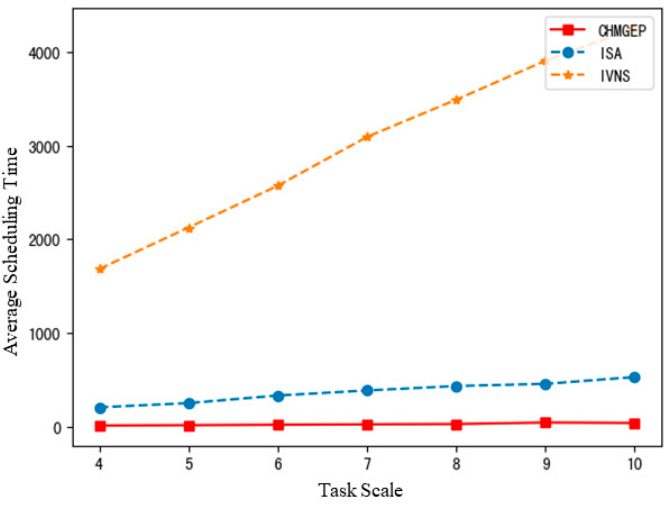
Figure 12. The comparison with metaheuristic algorithms on scheduling time.